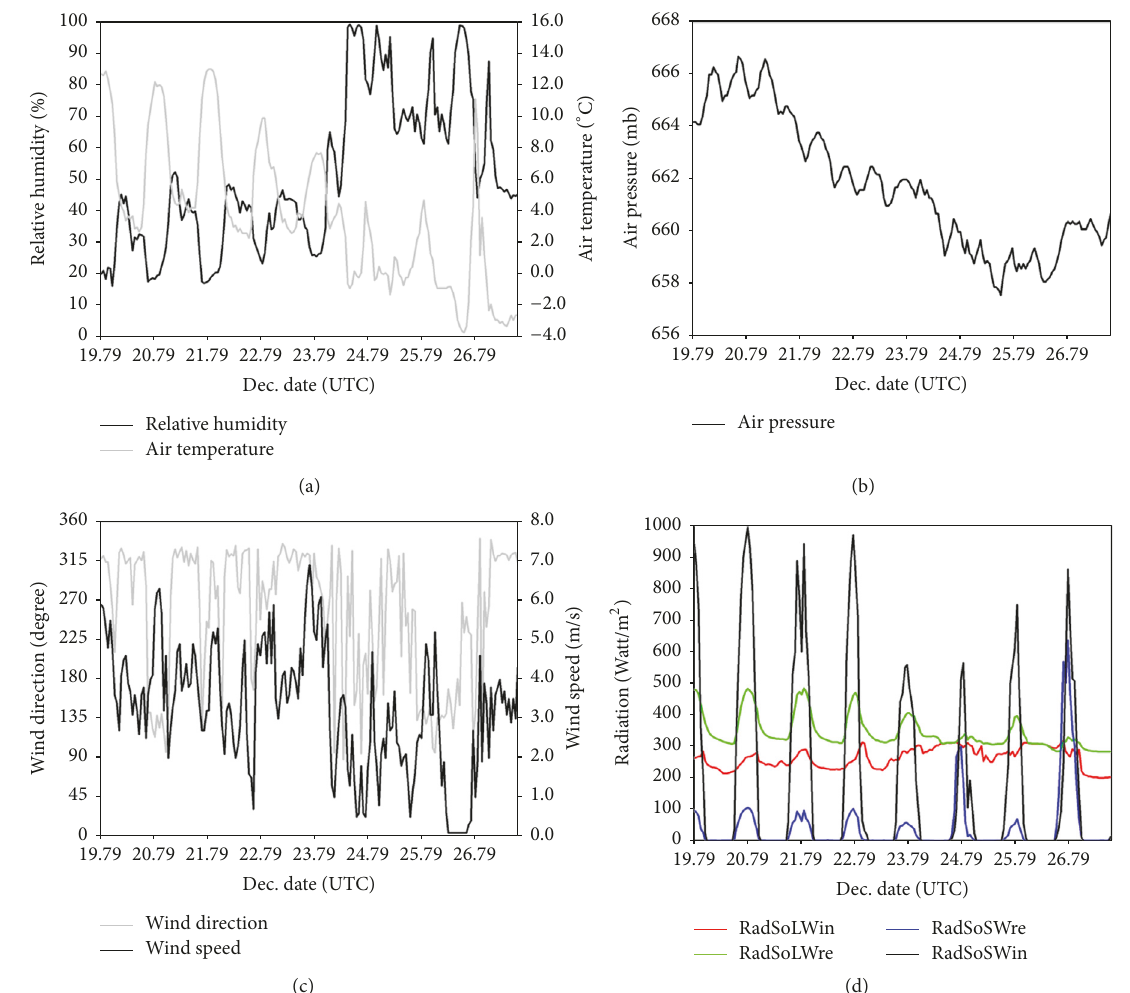
Figure 3: DGA automatic weather station time series from 19 March to 26 March 2015: (a) surface air temperature and relative humidity; (b) mean sea-level pressure; (c) wind speed and wind direction; and (d) incoming (black) and reflected (blue) shortwave radiation, and incoming (red) and outgoing (green) long-wave